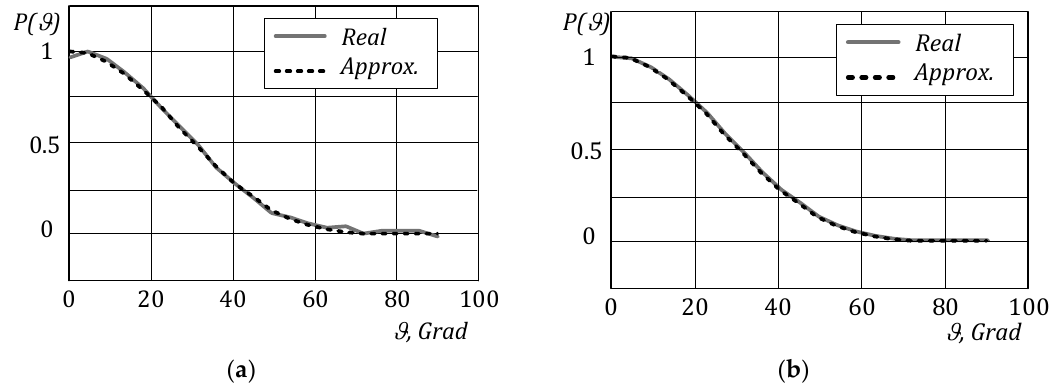
Figure 5. Approximation: ( a ) in case of no random measurement errors; ( b ) in case of random measurement errors.